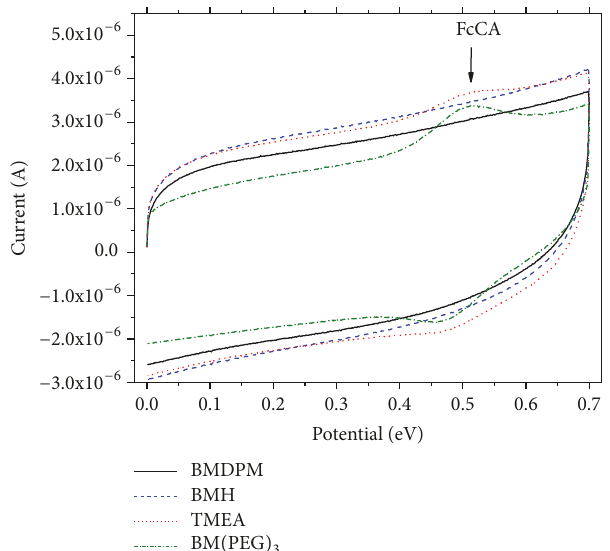
Figure 3: PMPMS thiols remaining after crosslinking support immobilization of disulfide-terminated probes through thiol/disul- fide exchange reactions, leading to hybridization signal (peak at around 0.5 V) for TMEA and BM(PEG) 3 crosslinked films. Lack of signal in BMH and BMDPM treated films indicates near complete conversion of PMPMS thiols. Conditions of PMPMS deposition: 10 mMPMPMS in DMF,2 hrs. PMPMS crosslinking: 1 mM crosslinker in DMF, 17